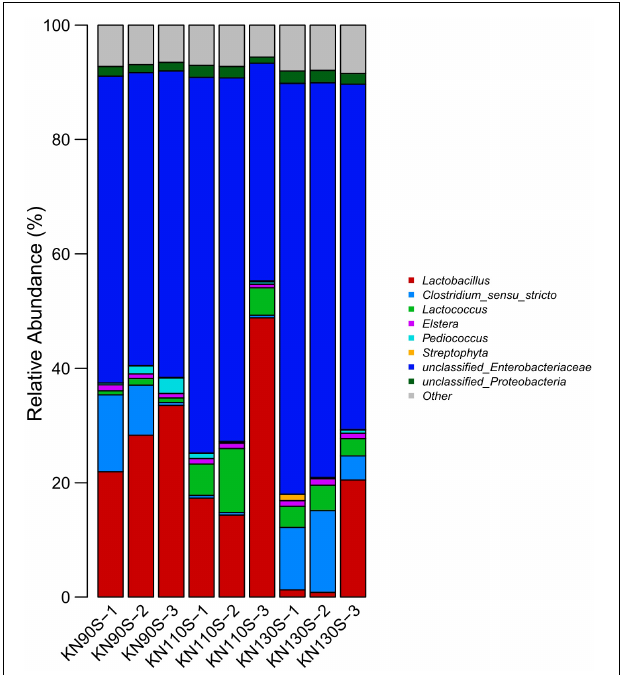
FIGURE 3 | Differences in the bacterial community of king grass silage at the phylum level (KN90S, king grass silage harvested at growth periods of 90 days; KN110S, king grass silage harvested at growth periods of 110 days; KN130S, king grass silage harvested at growth periods of 130 days).